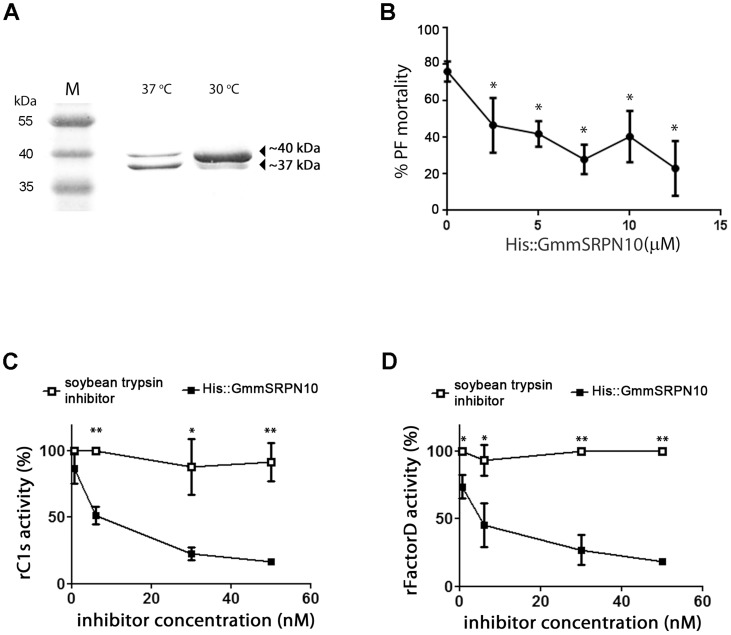
Expression of His::GmmSRPN10 is temperature sensitive and the expressed protein inhibits killing of PF trypanosomes by HS in vitro.(A) Recombinant expression of His::GmmSRPN10 results in an intact (∼40 kDa) and truncated (∼37 kDa) protein fraction that were identified using mass spectrometry. Expression at 30°C enriches the intact fraction. (B) Supression of trypanocidal activity by His::GmmSRPN10 can be achieved by pre-treating HS with the recombinant protein. (C–D) His::GmmSRPN10 inhibits the activity of rC1s and rFactorD, recombinant human complement cascade serine proteases, in a concentration dependent manner. Inhibition of the complement cascade serine proteases at comparable concentrations were not observed in the controls performed in tandem using a commercially available soybean trypsin inhibitor.